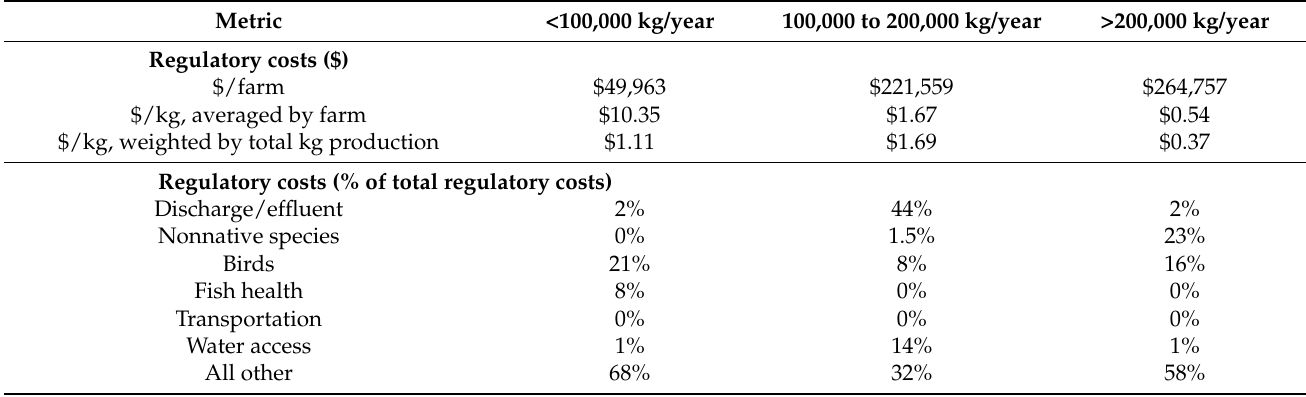
Table 11. Farm size effects of regulatory